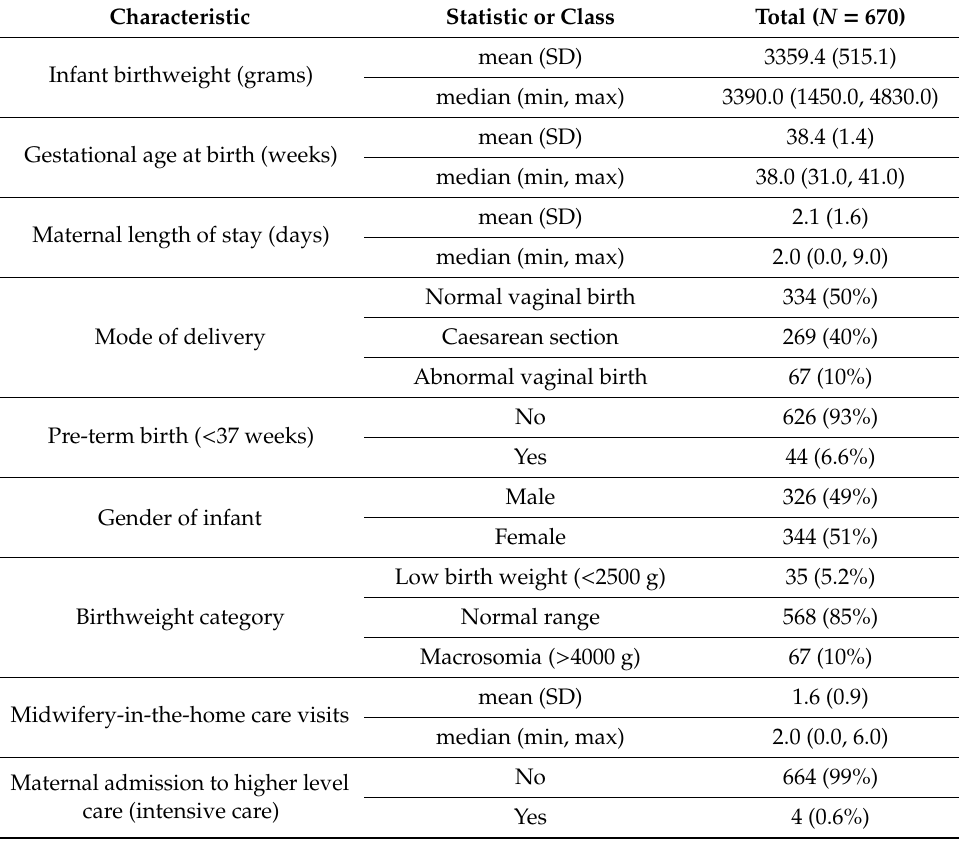
Table 3. Participant demographics and healthcare-resource use summary